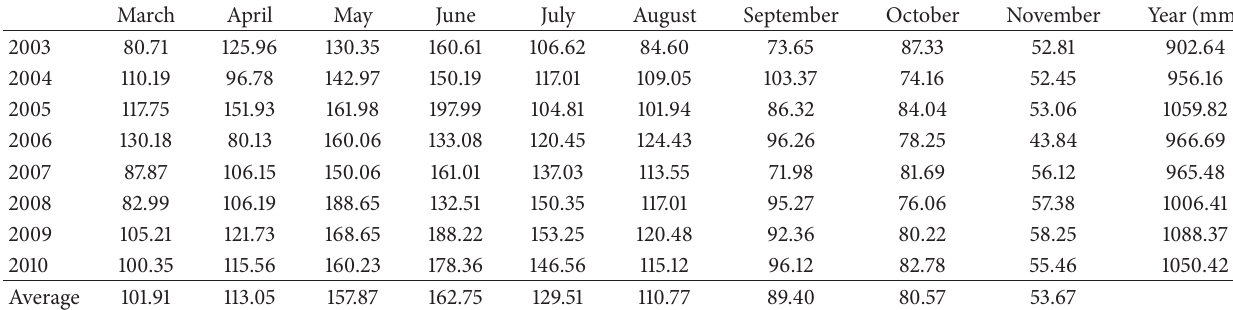
Table 6: Monthly evaporation of Dongping Lake (unit: mm).